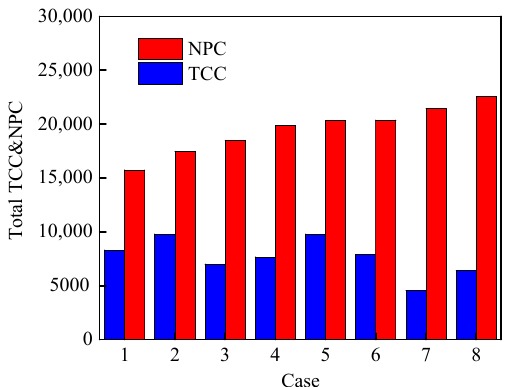
Figure 10. Computed total capital cost (TCC) and total net present cost (NPC) (0.5 kW wind turbine, PV and biogas genset).